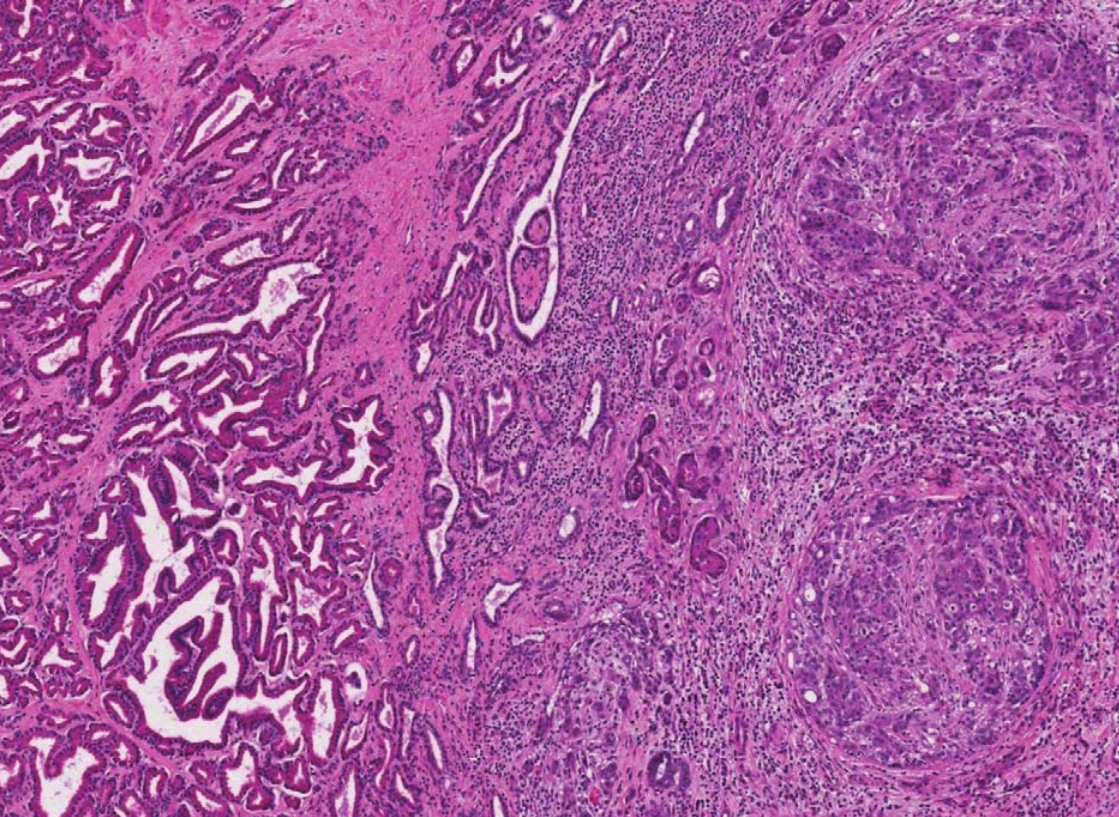
Figure 3. Intraprostatic Ace-1 tumor in an immunosuppressed dog. Ace-1 cells formed poorly demarcated masses (right side of image) that invaded the prostatic glands and ducts. The cells were polygonal to mildly spindle-shaped (epithelial-mesenchymal transition) and formed nests and papillary projections, frequently filling acini. Larger papillary projections were associated with coagulation necrosis. Lymphoplasmacytic inflammation and desmoplasia surrounded the affected acini and between the border of the invasive neoplastic cells into the normal prostatic tissue to the left. The left side of the image is composed of numerous variably sized, hypercellular glands lined by tall columnar to cuboidal epithelium and occasional prominent intra-luminal papillary projections (benign prostatic hyperplasia)